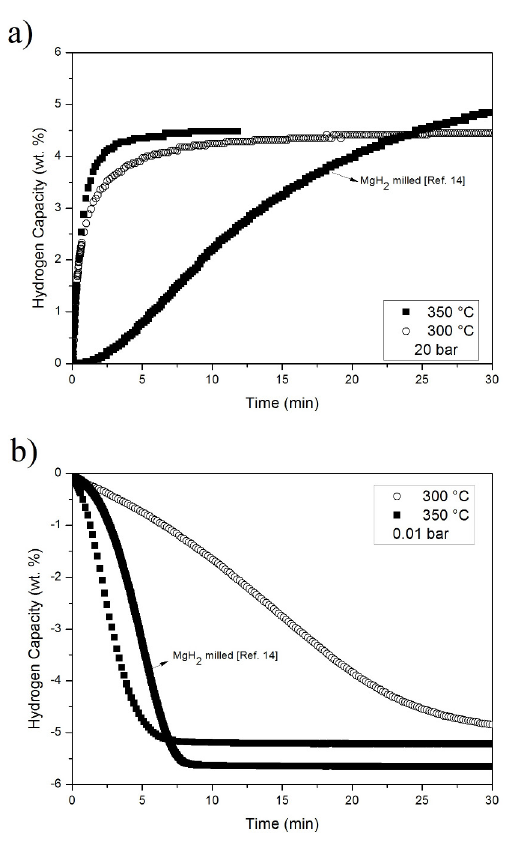
Figure 4. Hydrogen absorption (a) and desorption curves (b) of MgH2 milled for 24 hours and MgH2 + 5 wt. % MWCNT (ball-to-powder mass ratio of 40:1) with a pressure of 30 bar. For the mixture of MgH with 1 % MWCNT the HRBM 2 time was 6h and 1.5 h for 5 % MWCNT.